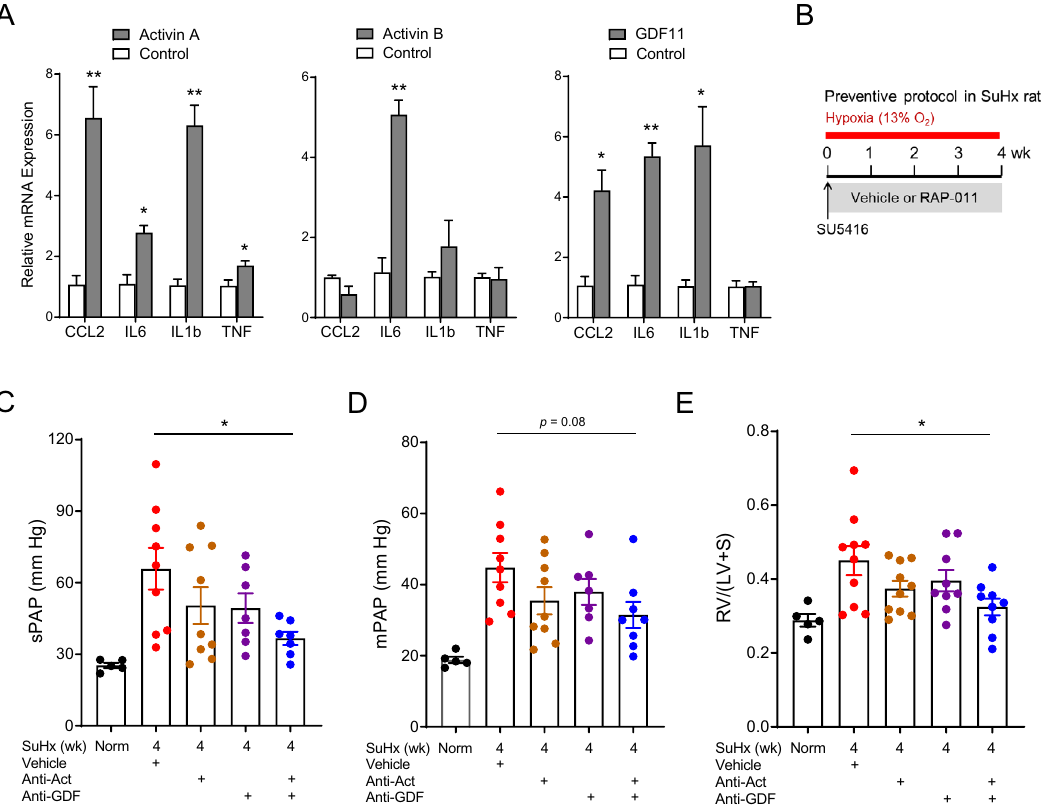
Figure 3. Multiple ligands contribute to macrophage activation in vitro and cardiopulmonary remodeling in a SuHx rat model of PH. ( A ) Expression of markers of macrophage activation in THP-1 monocytes in vitro without treatment (Control) or after treatment with activin A (5 ng/ml), activin B (50 ng/ml), or GDF11 (5 ng/ ml). Analysis by unpaired t-test (* P < 0.05, ** P < 0.01 vs. control). ( B ) Experimental approach used to test effects of multi-ligand inhibition in a SuHx rat model of PH. Rats were treated with a single dose of SU5416 (20 mg/ kg, s.c.), exposed to normobaric hypoxia (13% O 2 ), and treated s.c. twice weekly with separate antibodies against activin A and activin B (anti-Act, 10 mg/kg each), an antibody with dual specificity for GDF8 and GDF11 (anti- GDF, 10 mg/kg), combined anti-Act and anti-GDF, or vehicle (PBS) for 4 weeks starting one day post SU5416. ( C ) sPAP, ( D ) mPAP, and ( E ) Fulton index. Data are means ± SEM (n = 5–9 rats per group). Analysis by one-way ANOVA and Tukey post hoc test (* P < 0.05, ** P < 0.01, **** P <